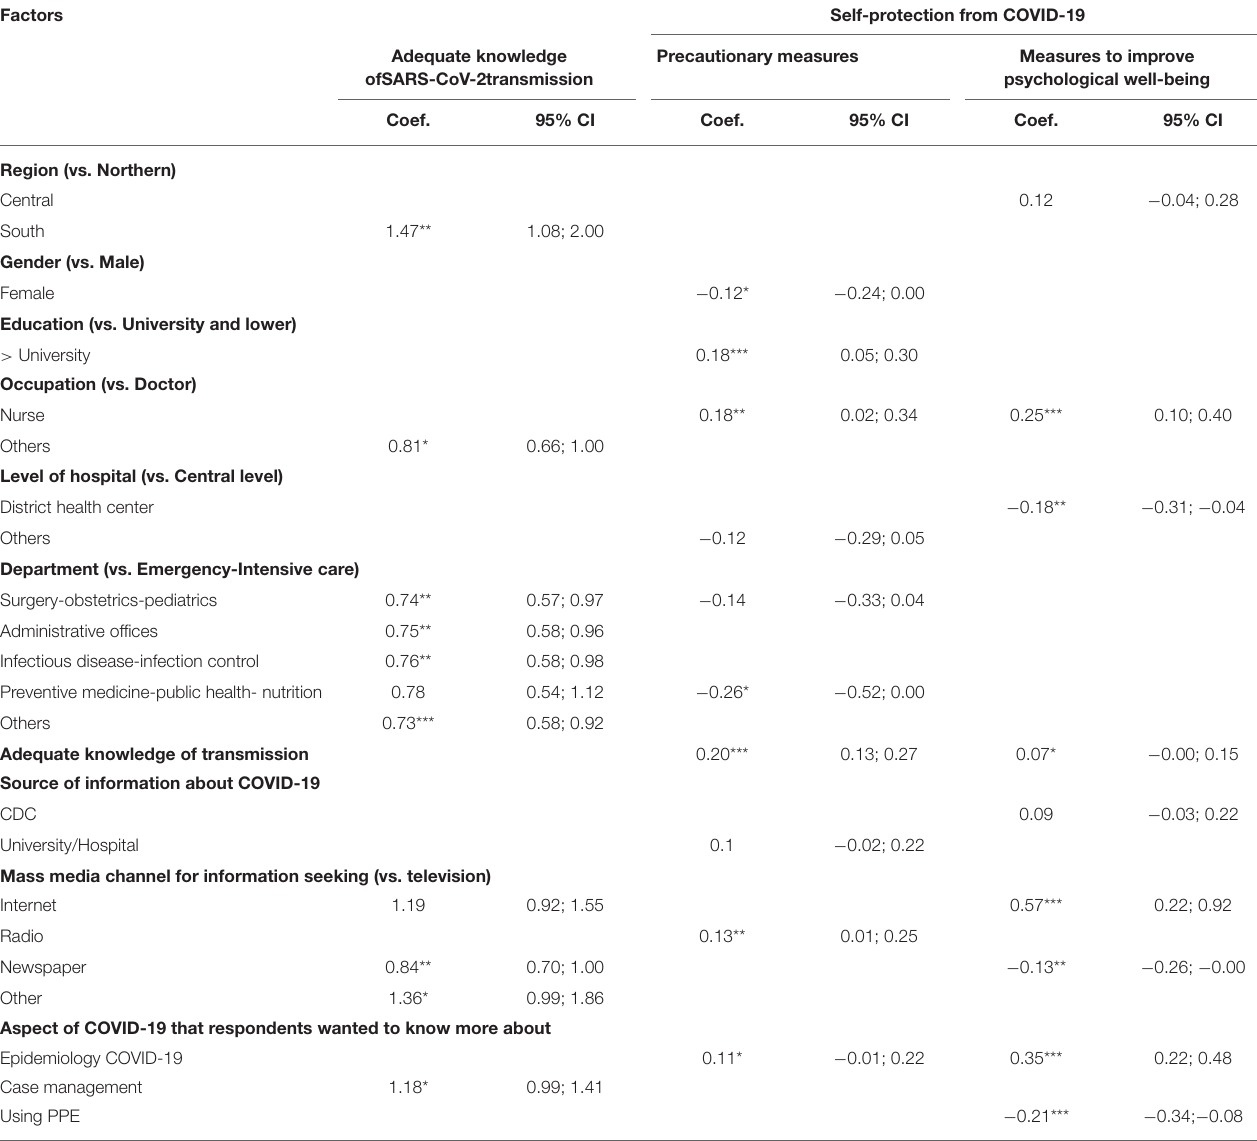
TABLE 4 | Associated factors of the knowledge and practices against the COVID-19. Factors Self-protection from COVID-19 Adequate knowledge Precautionary measures Measures to improve ofSARS-CoV-2transmission psychological well-being Coef.